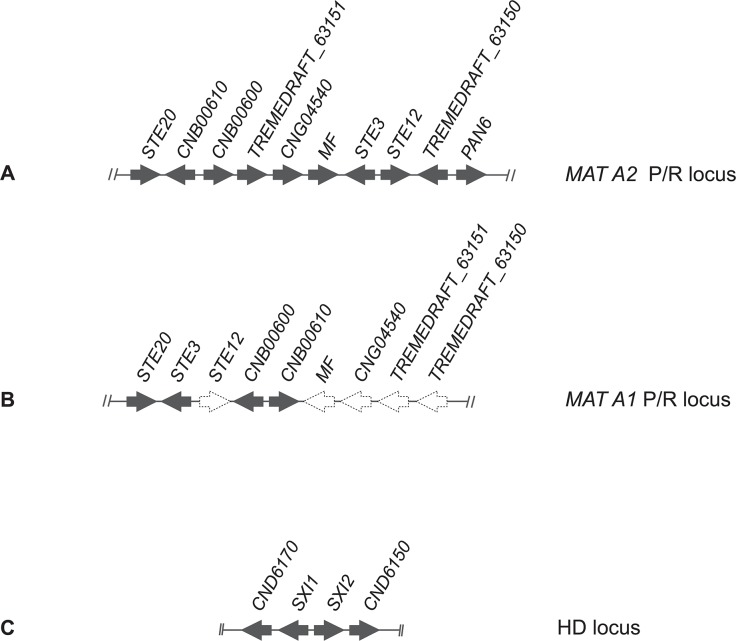
Schematic representation of Cryptococcus flavescens gene cluster organization of (A) MAT A2 inferred based on the NRRL Y-50378 genome sequence; (B) MAT A1 gene organization predicted based on PCR-approaches (dashed arrows); and (C) HD locus inferred based on the NRRL Y-50378 genome sequence.